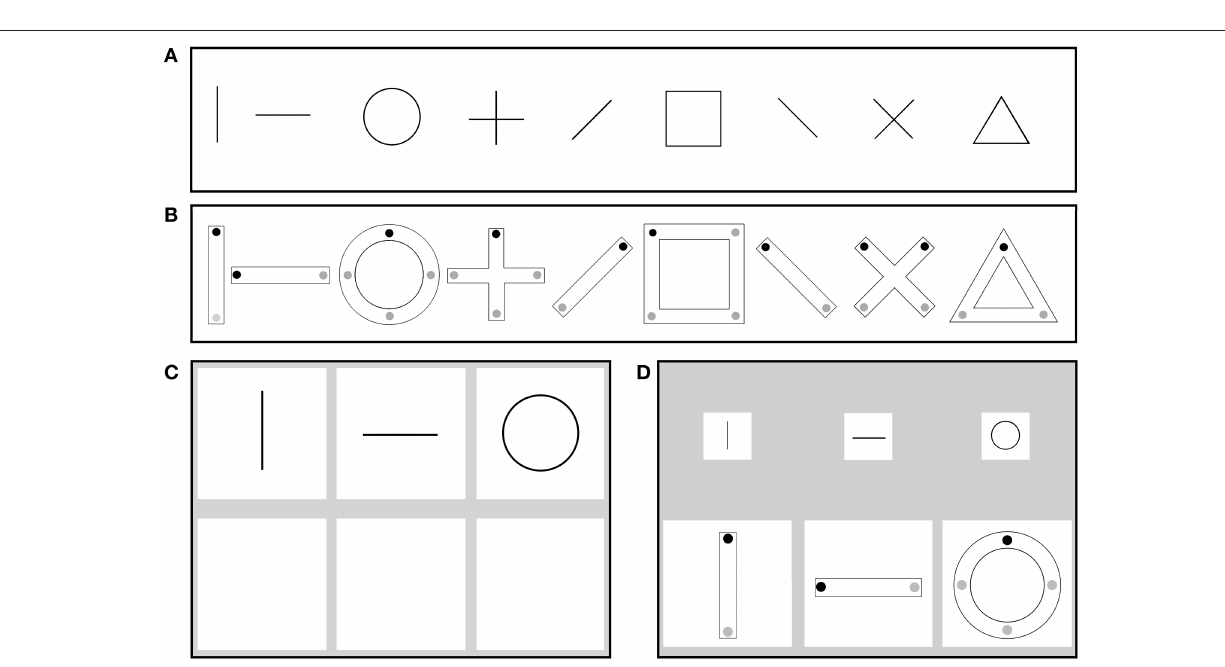
and the total score quantifies how accurately the participants copied the